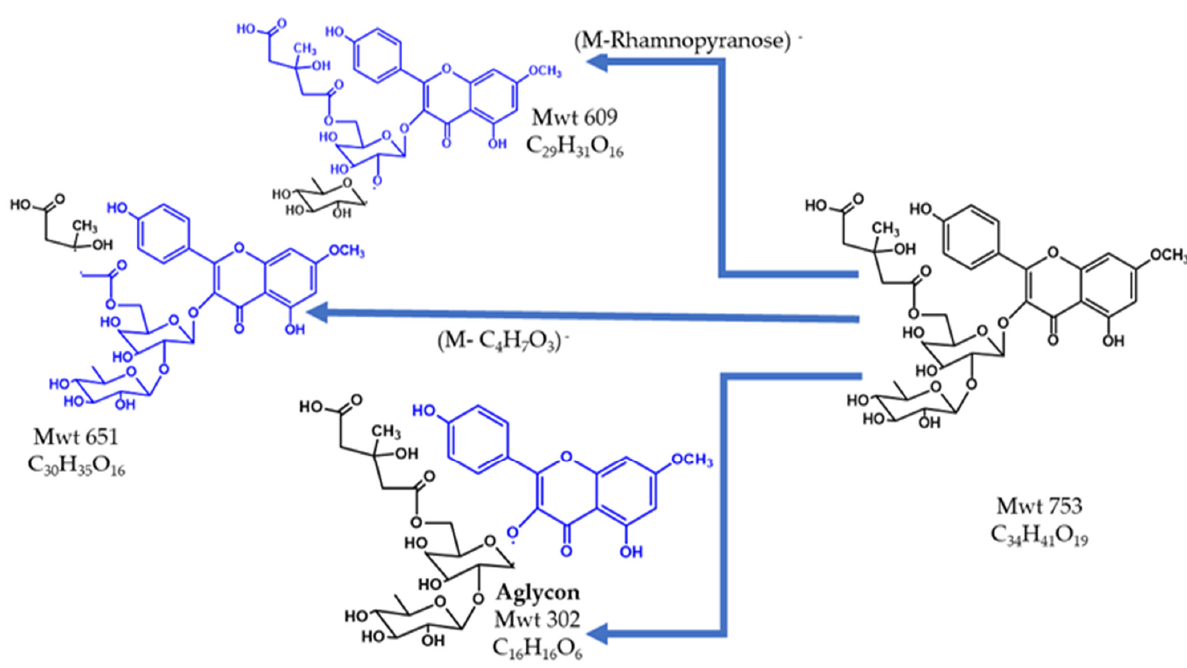
Figure 5. The structure and fragments of QueHMG.